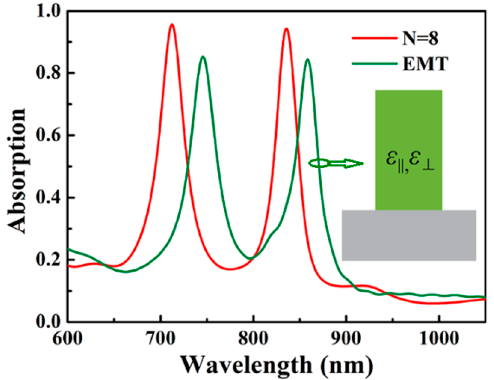
Figure 4. Absorption response of the HRA with parameters the same as those in Figure 1a, and absorption response of the equivalent structure.